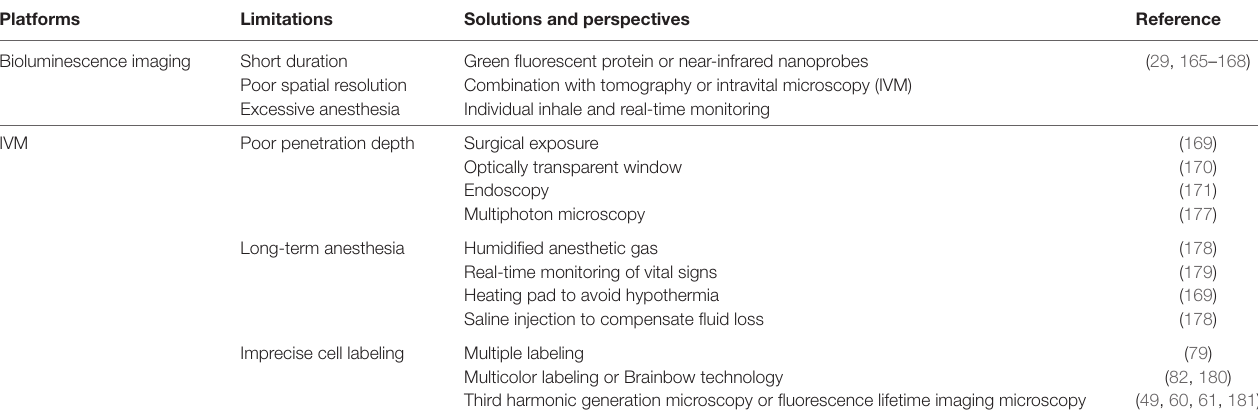
Table 3 | Challenges and solutions for optical imaging techniques during in vivo macrophage